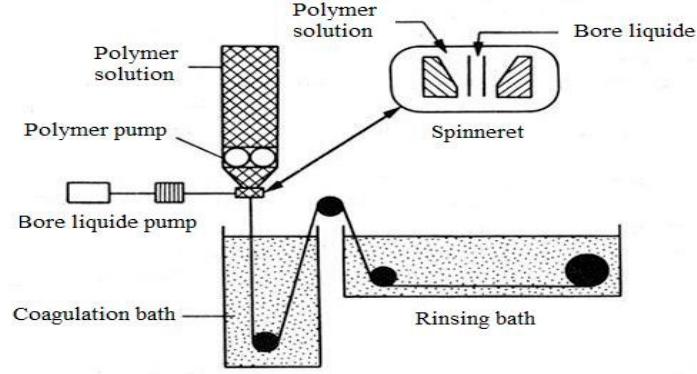
Figure 1. Apparatus for the fabrication of hollow fibers (HFs) [5].